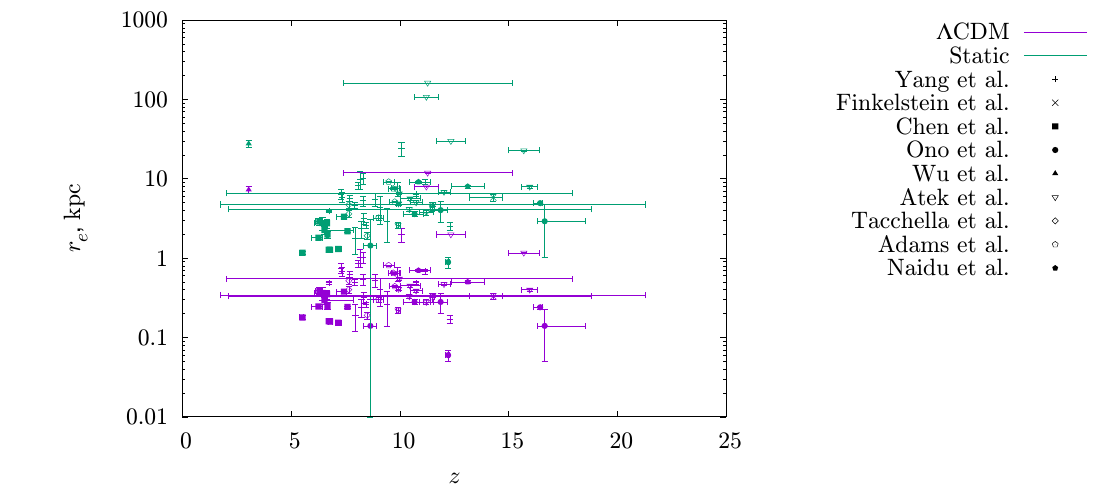
Figure 4. JWST galaxy physical sizes (effective radii r e , in kpc) as estimated within the framework of the standard Λ CDM cosmological model [5,28,29,81–87] (purple points) and sizes of the same galaxies as they would appear in a static Universe (green points), for which we have used the formalism of Zwicky’s dissipative (tired-light)